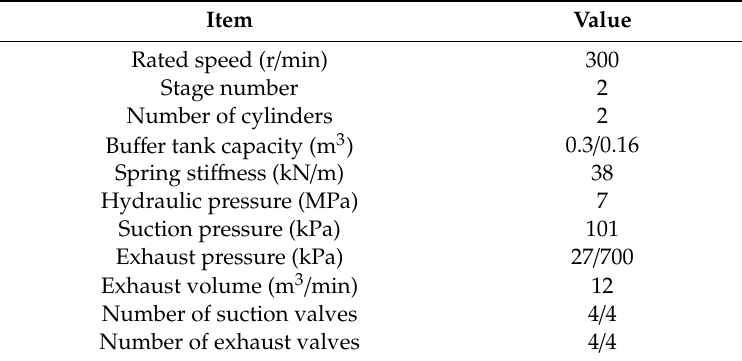
Figure 3. Two-stage reciprocating compressor with a stepless capacity regulation system (SCRS). Table 2. Operation parameters of the compressor and the